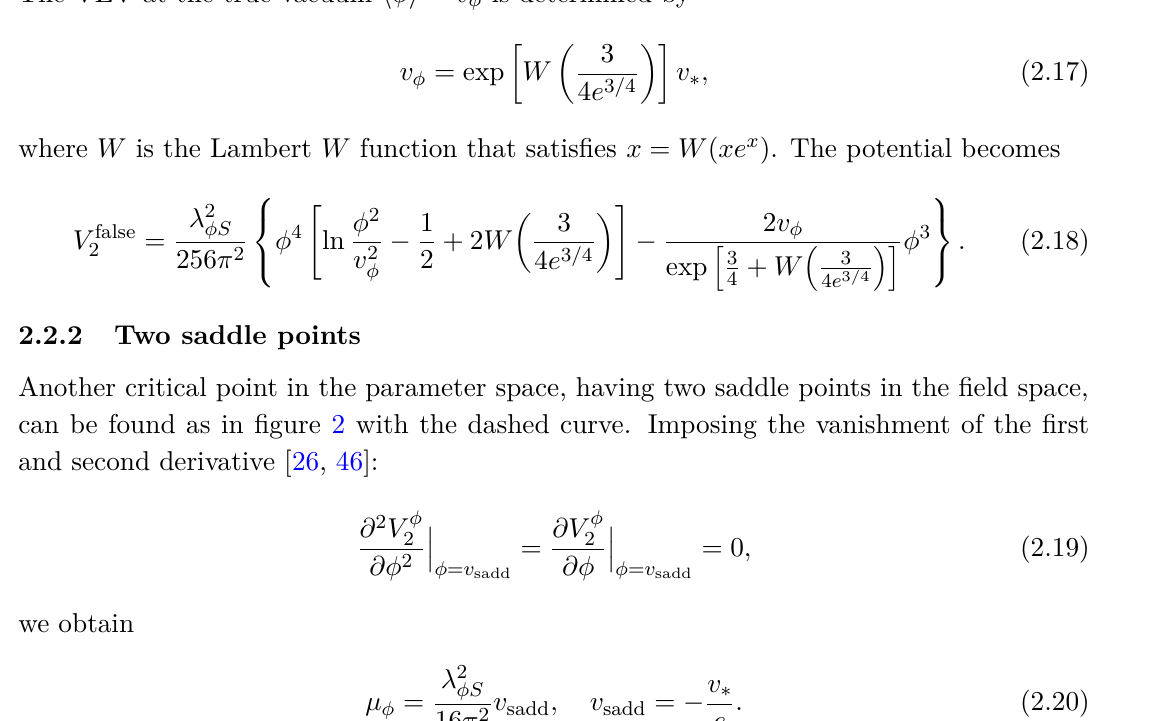
The VEV at the true vacuum h φ i = v